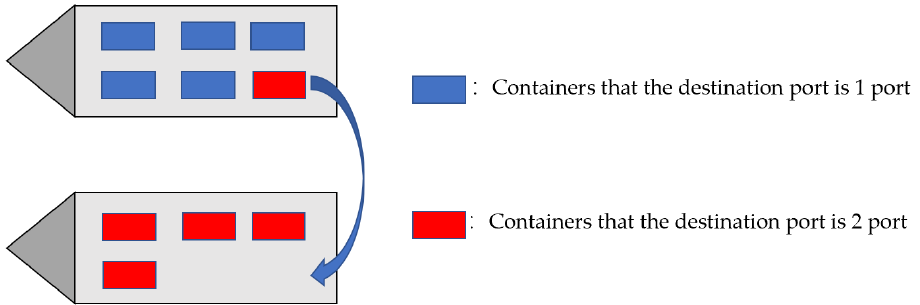
Figure 4. The inefficient transportation of feeders.